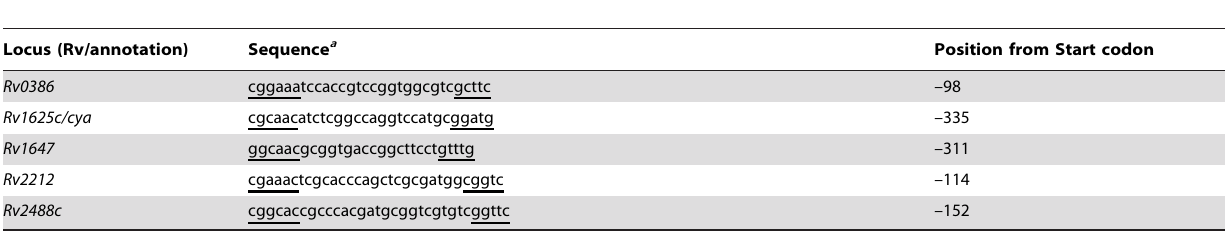
Three hundred fifty base pair long DNA sequences upstream to the AC-encoding genes were analyzed to identify SigH-recognition sequences. a The underlined sequences represent putative SigH-recognition sequences (c/gGGAAc-N 17–21 -c/gGTTc/g) in the 5’-UTR of the respective genes.